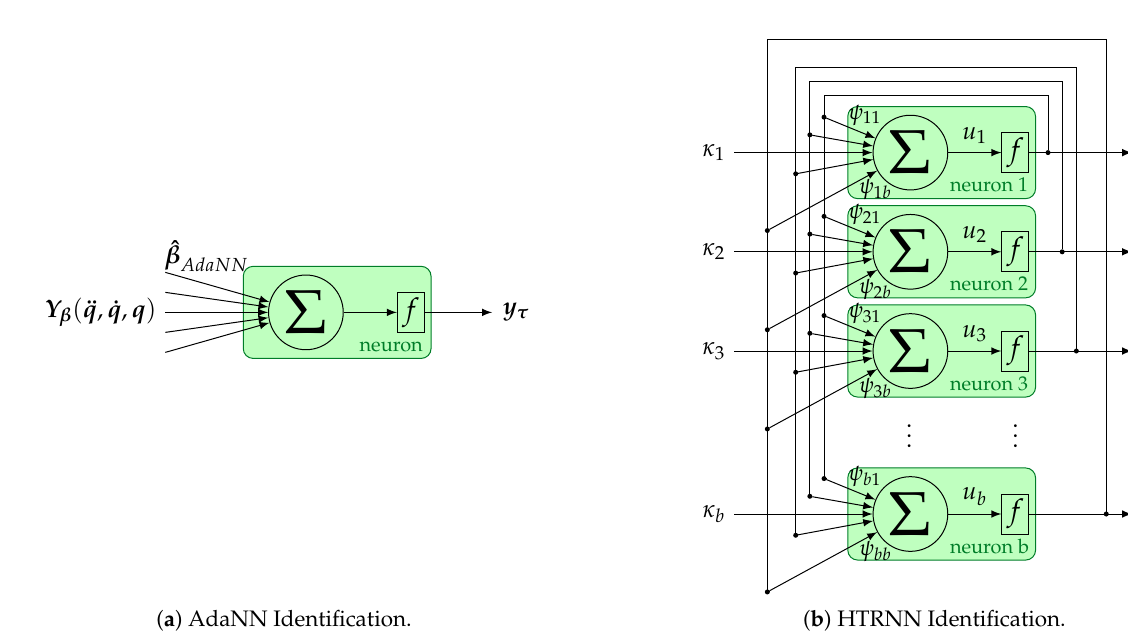
Figure 5. Adaline and Hopfield Neural Networks used for Inertial Parameter